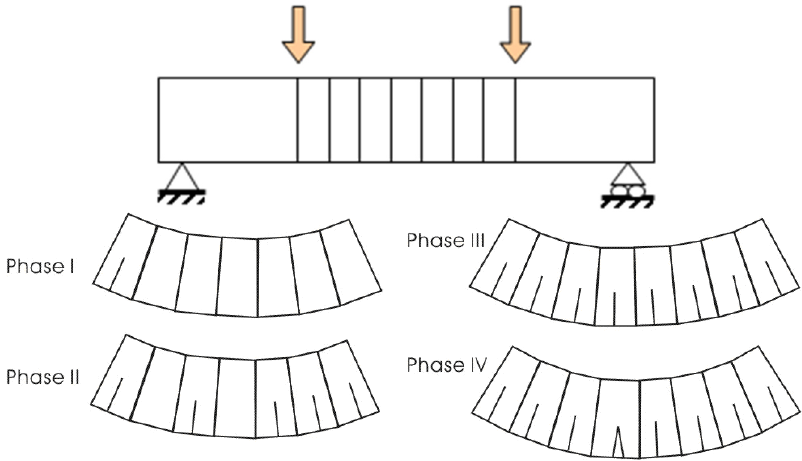
Figure 6. Model for pure bending region in flexural